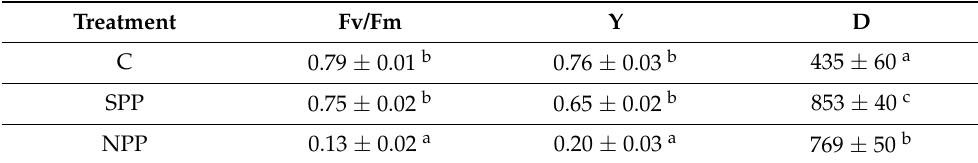
Table 1. Effect of cross-tolerance on maximum efficiency of PSII photochemistry, Fv/Fm, and efficiency of PSII photochemistry, Y, and density of olive leaves subjected to subsequent drought stress. Significant differences between the means (at p < 0.05, according to ANOVA) appear with different letters. Values are means ± standard error ( n = 6), where ‘ n ’ is the number of replicates for each group.